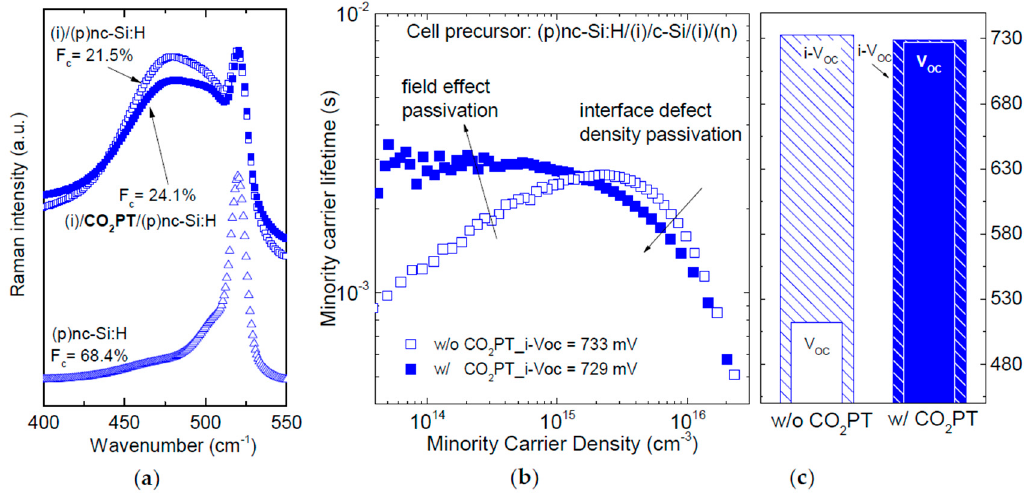
Figure 4. ( a ) Raman spectra as function of wavenumber of (p)nc-Si:H film on variable substrate layers (laser 442 nm). The extracted value of crystalline fraction ( F C ) is reported next to each spectrum. ( b ) Minority carrier lifetime measured on precursors fabricated on textured wafers with and without a CO 2 plasma treatment with the same 25-nm thick (p)nc-Si:H layer. ( c ) Implied- V OC extracted from ( b ) and V OC measured on the completed cells. Figure adapted from [47].